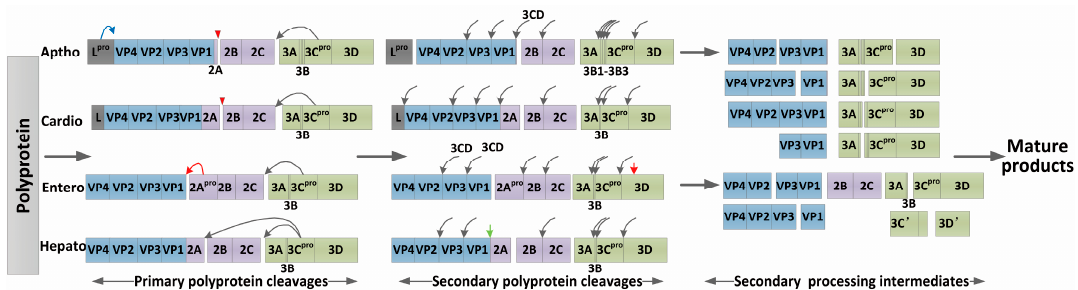
Figure 2. Polyprotein processing in different genera of the picornavirus family [23,28]. The release of mature and functional proteins from the polyprotein is dependent on primary and secondary cleavages and polyprotein processing differs slightly among diverse picornaviruses. In primary cleavage, L pro functions in apthoviruses by freeing itself (blue arrow), whereas the cleavage of P1-P2 is mediated by ribosome skipping in apthoviruses and cardioviruses (red triangle) [29]. The proteolytic 2A pro of enteroviruses is involved in primary cleavage and 3D pol cleavage to produce 3D’ intermediate (red arrows). 3C pro and 3CD are responsible for a proportion of primary cleavages and almost all secondary cleavages (black arrow). The hepatovirus VP1-2A cleavage can be achieved by a host cell proteinase (green arrow). See the text for details.